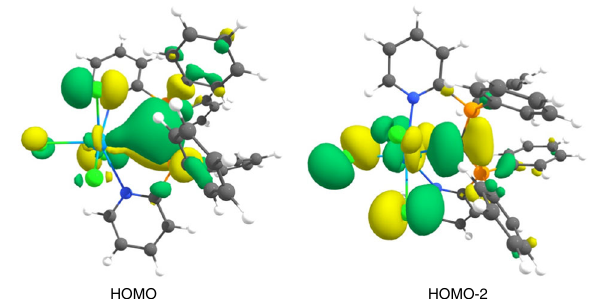
Fig. 4 Shape of the HOMO and the HOMO-2 of complex 2 . The isosurface value is 0.03 e Å − 3